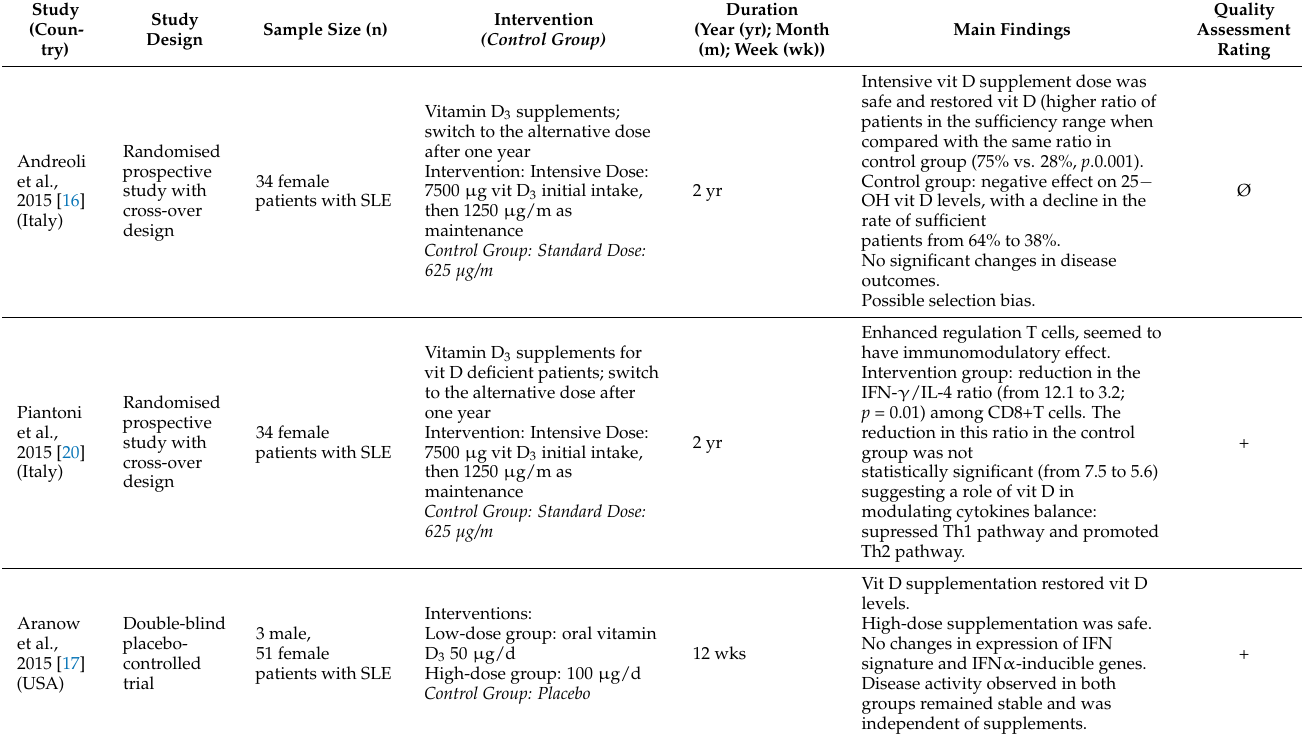
Table 1. Characteristics of included studies on vitamin D supplementation